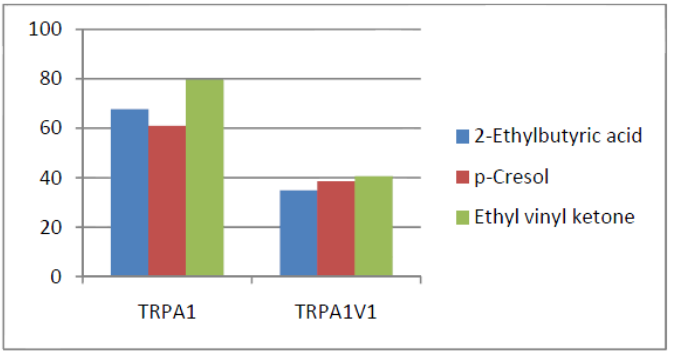
Figure 7. Examples of compounds that activate TRPA1 > TRPA1V1, but not TRPV1.